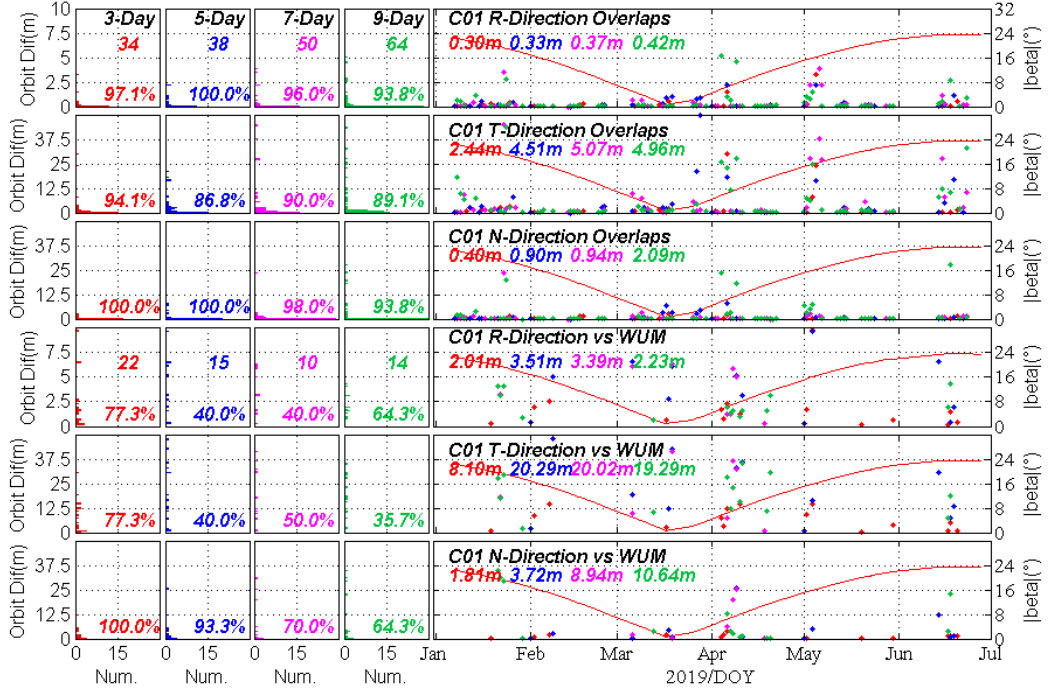
Figure 6. The results of SLR-only orbit determination for C01.